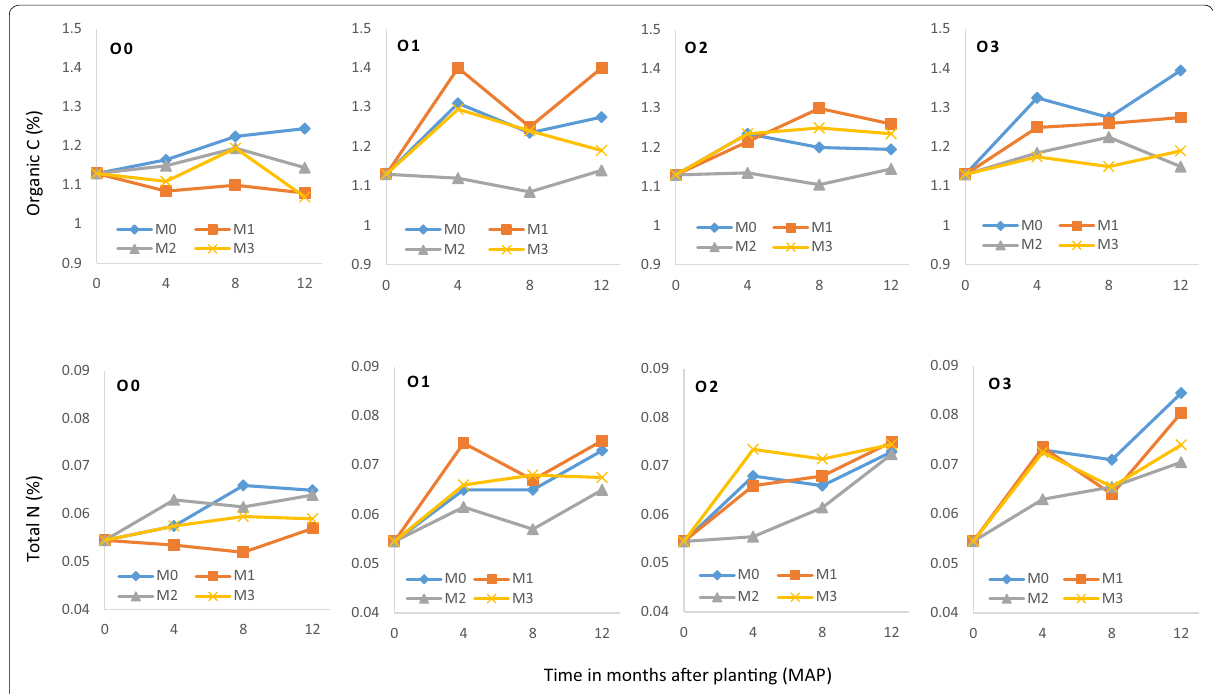
Fig. 2 The interaction effect between organic and mineral fertilizer on organic carbon and total